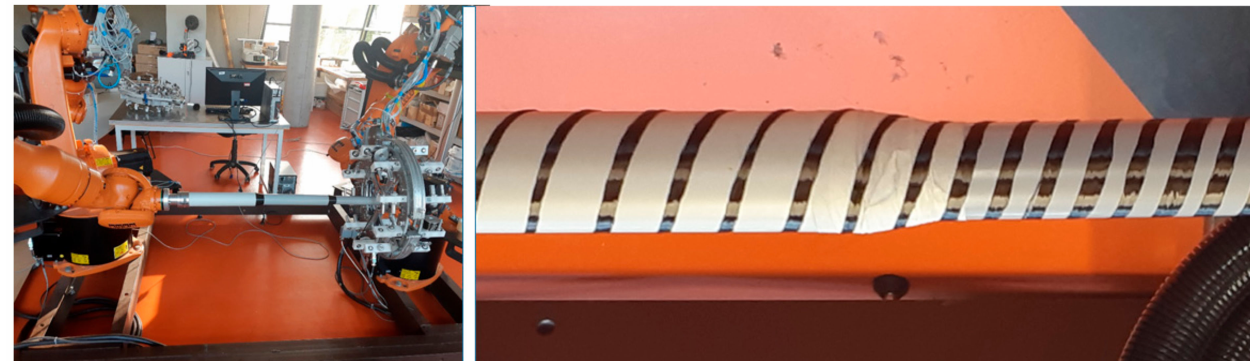
Figure 9. The attachment of the frame to REE and the fiber-processing head before starting the winding process (on the left). Fiber winding density for constant winding angle α = π r 2 = 20 [mm] (on the